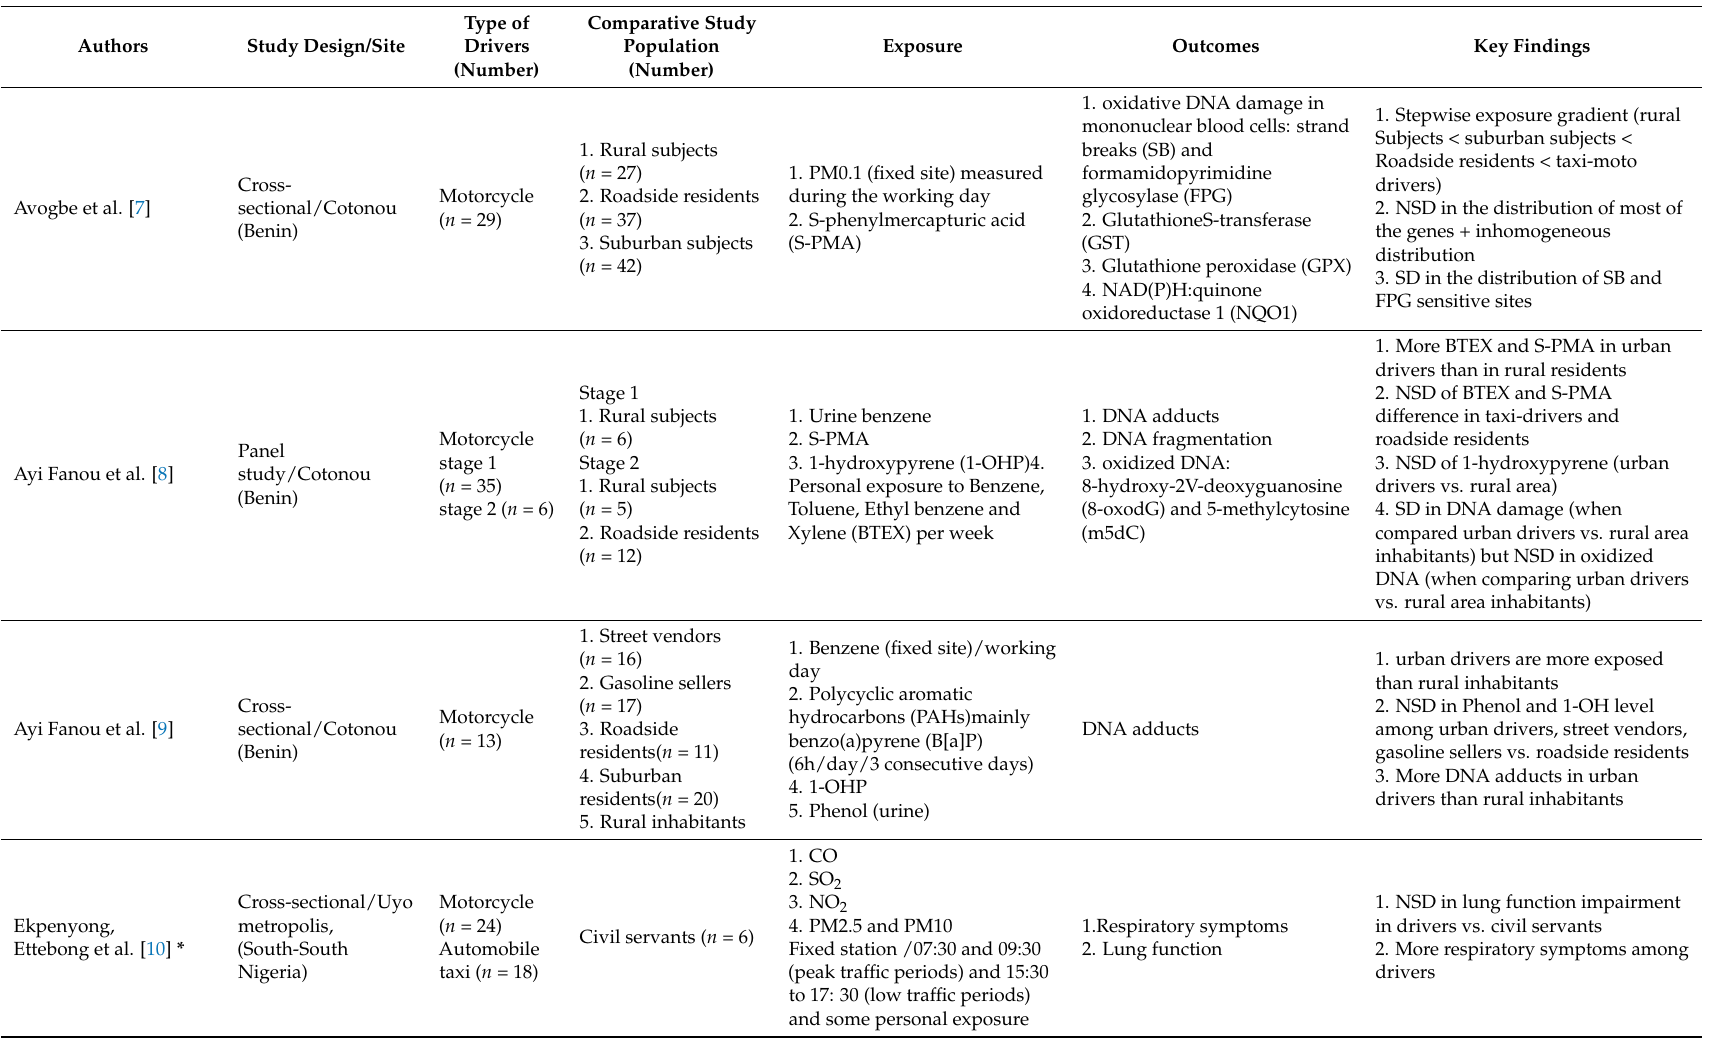
Table 3. Studies on motorcycle taxi drivers included in the